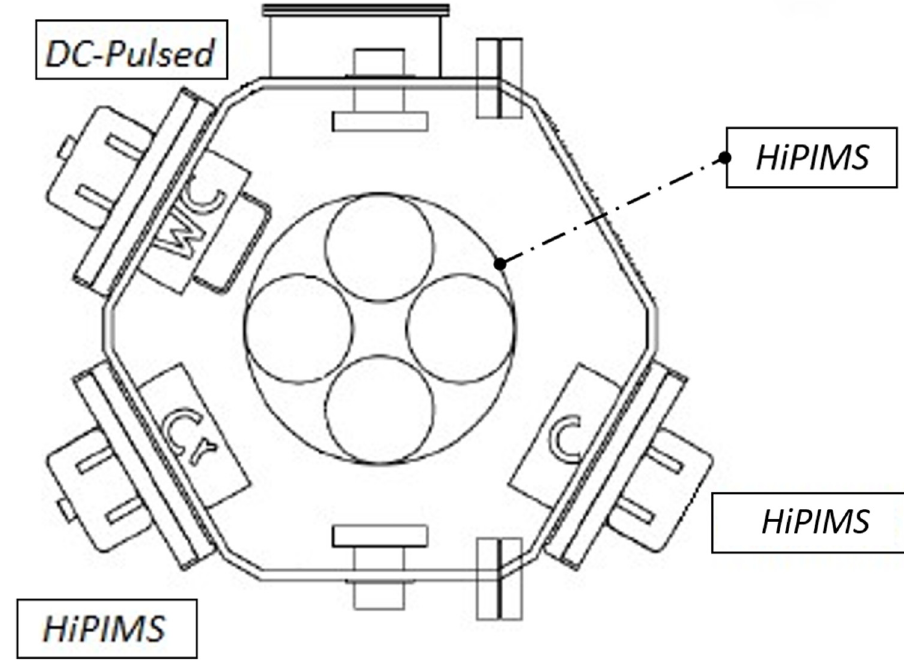
Figure 2. Scheme of the HiPIMS chamber in a horizontal